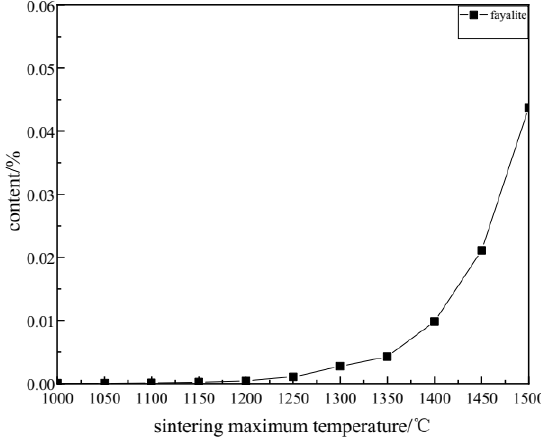
Figure 6. Change of fayalite content in sinter ore in case of straw charcoal